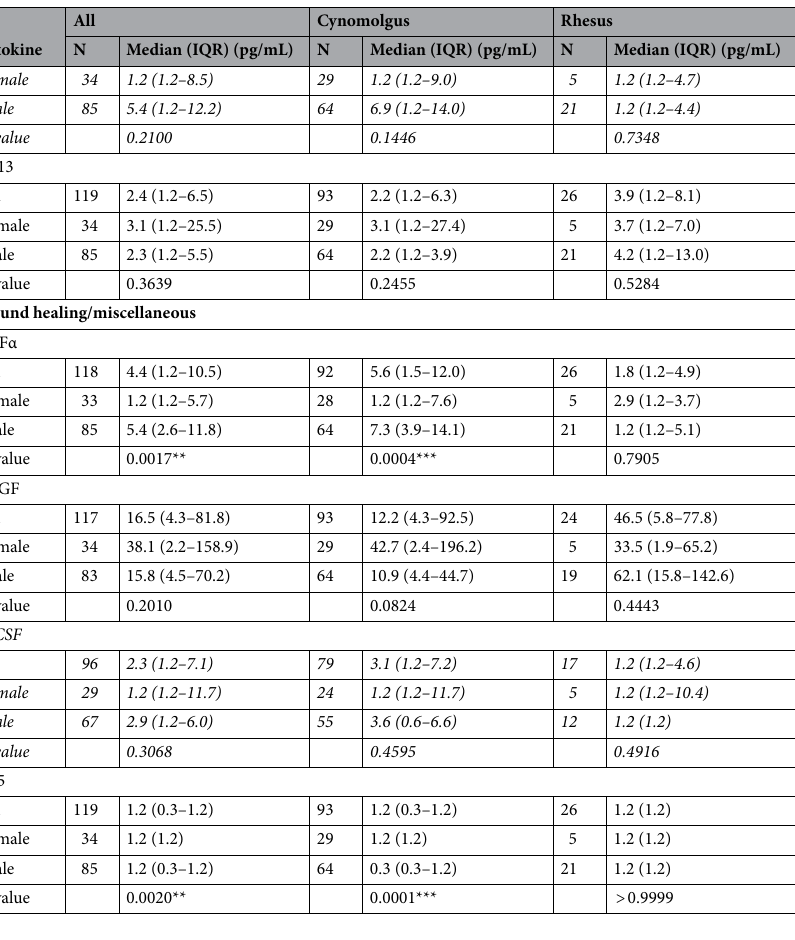
Table 2. Cytokine detection in all NHPs, cynomolgus, and rhesus macaques. Regular text = accept; italicized = marginal. Cytokines with validation outcome of reject are not included. *p < 0.05; **p < 0.01; ***p < 0.001; ****p <